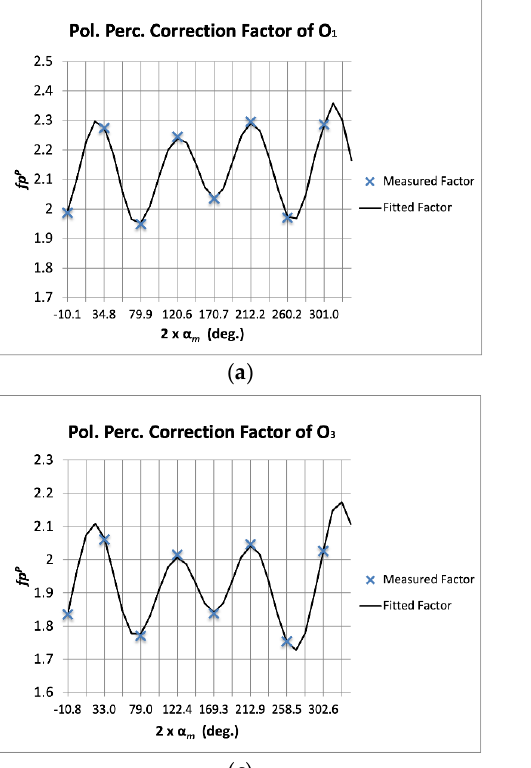
( b ) Figure 6. Measured polarization percentage error ( ε p Pm , ( a )) compared to the corrected ones ( ε p Pc , ( b )). The calibrated errors are represented here as a function of the input polarization angles ( α in ). Table 3. Fitting parameters K i for each error term and polarimeter output. Index i